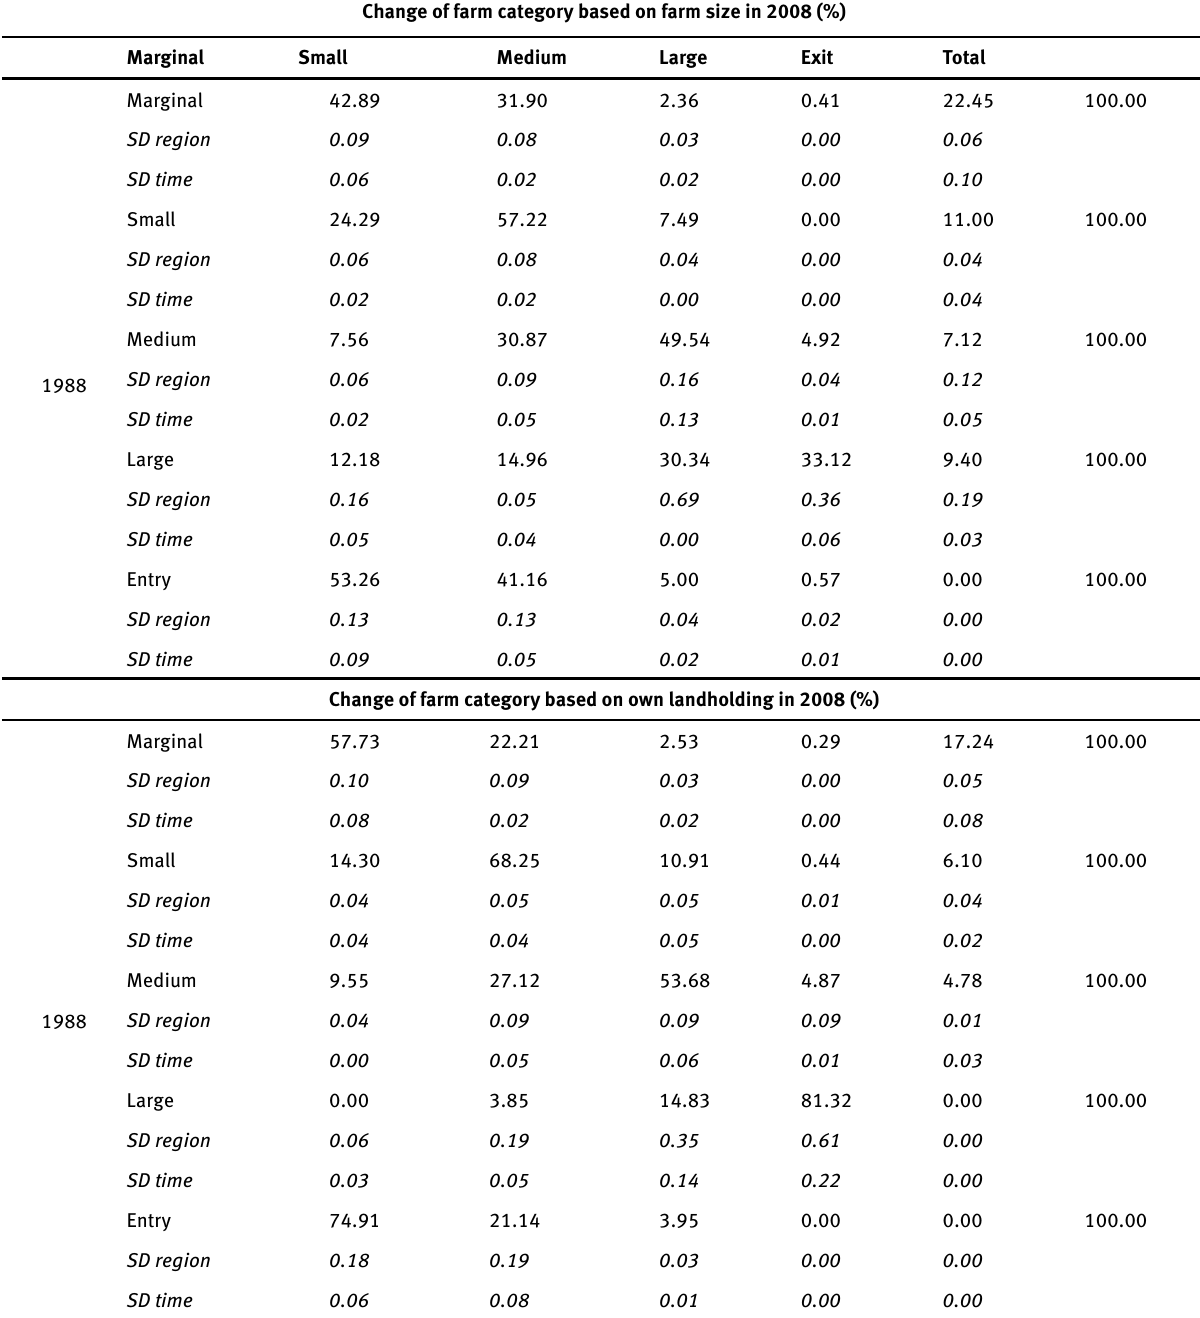
Table 1: Average transition probabilities and standard deviations across time & region of farm categories Change of farm category based on farm size in 2008 (%)